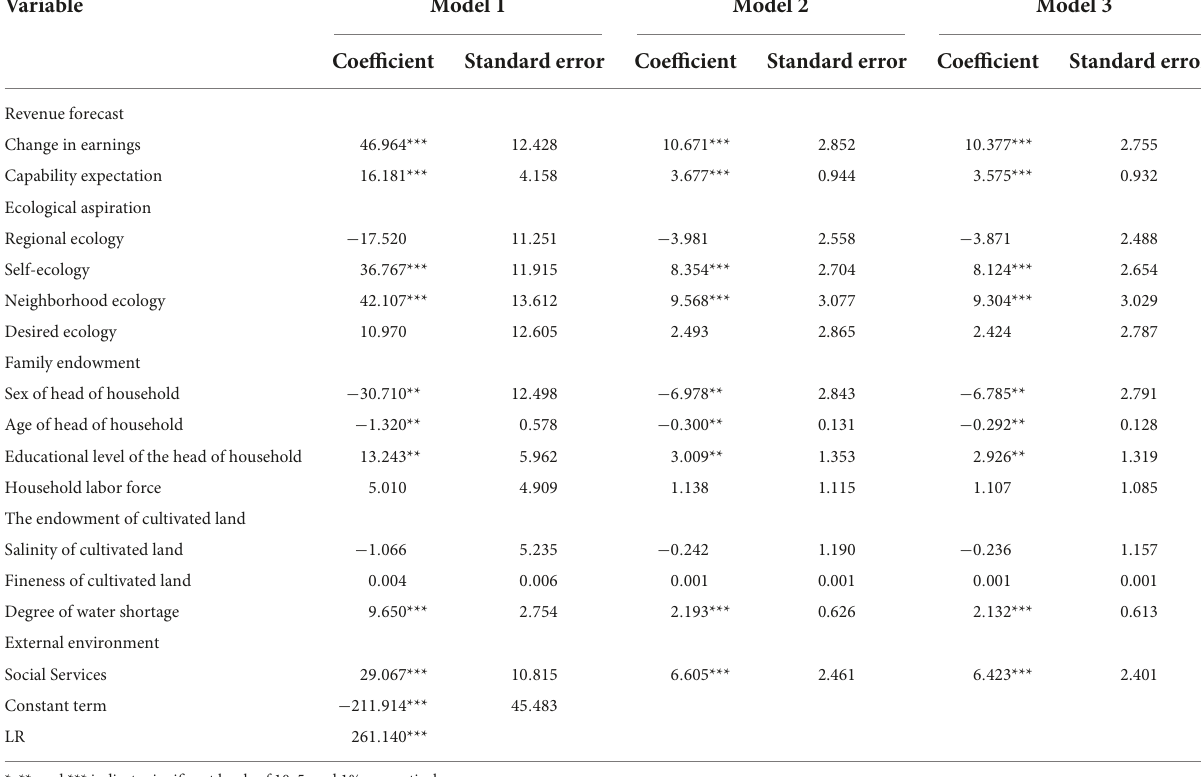
TABLE 5 Estimation results of Tobit model for the area of conversion of cropland to forest.